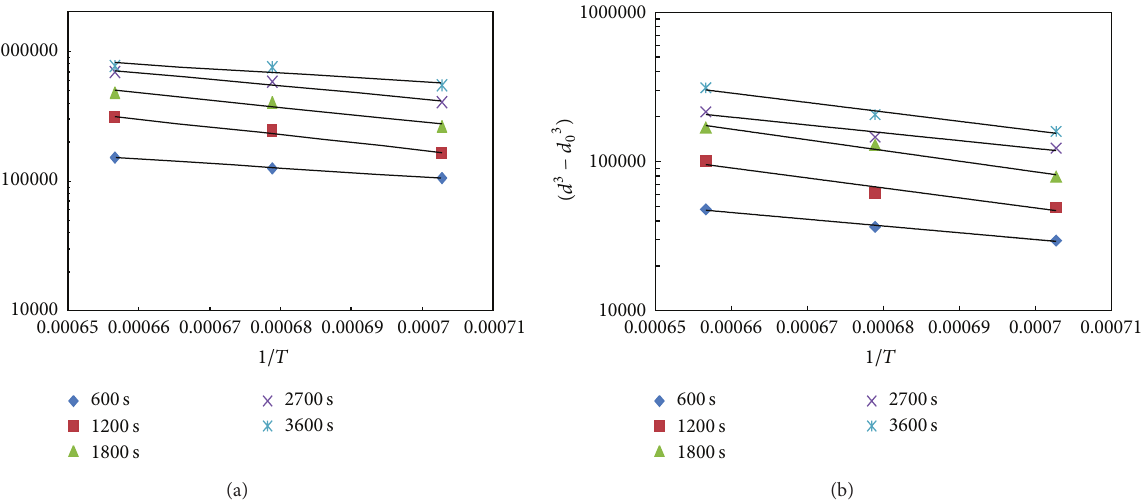
Figure 6: (𝑑 3 − 𝑑 03 ) versus 1/𝑇 plot for (a) X65 and (b) X70.